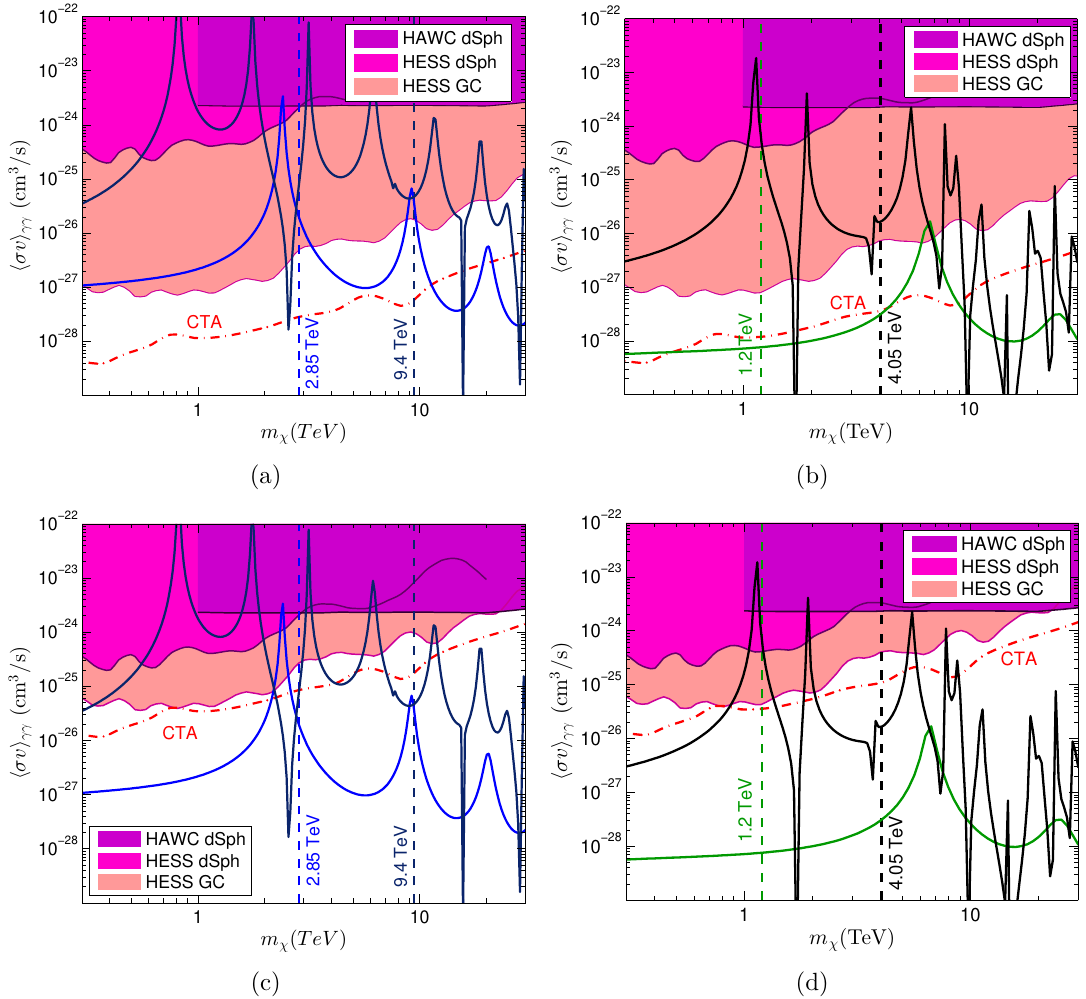
Figure 11. (Upper panels) Spectral line constraints on computed cross-section for different modules of EWDM including the real triplet (blue) and quintuplet (navy) (11(a)) in addition to the pseudo- real doublet (green) and quadruplet (black) (11(b)). The bounds from dwarf satellites are observed by HAWC [110] and HESS [116], and the constraints from GC are detected by HESS [117] based on NFW profile. CTA sensitivity (red dashed-dotted) is simulated using unbinned analysis for an Einasto profile [107]. The shaded areas are excluded by the relevant experiments. The vertical dashed lines show the freeze-out masses for corresponding model. (Lower panels) The same as the top plots, but Isothermal DM profile is considered for HESS constraint and CTA